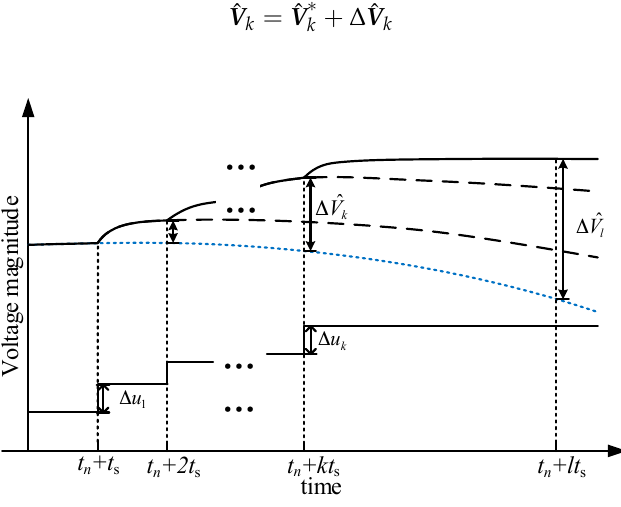
Figure 2. Voltage prediction based on trajectory sensitivity analysis.